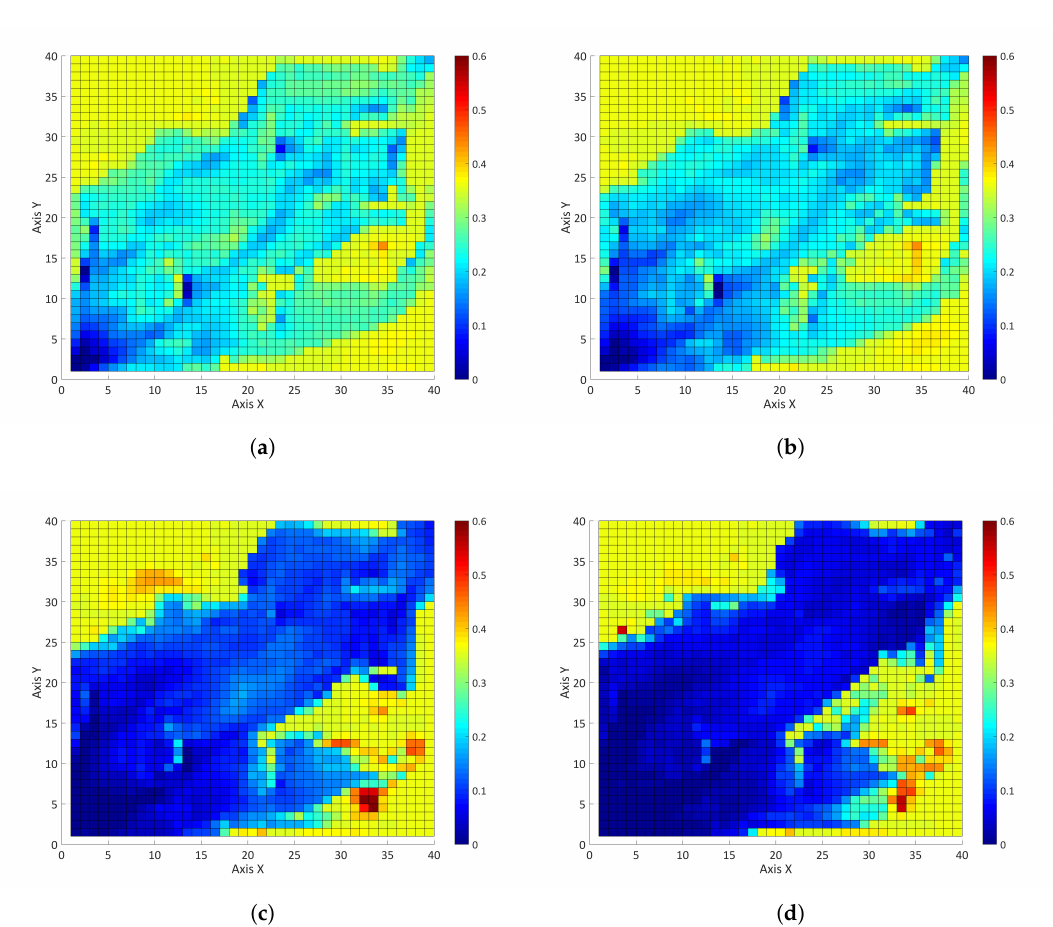
Figure 15. Oil recovered in a random permeability field for different partition coefficients: k c = 0.25 ( a ), k c = 0.50 ( b ), k c = 2 ( c ), and k c = 4 ( d ).